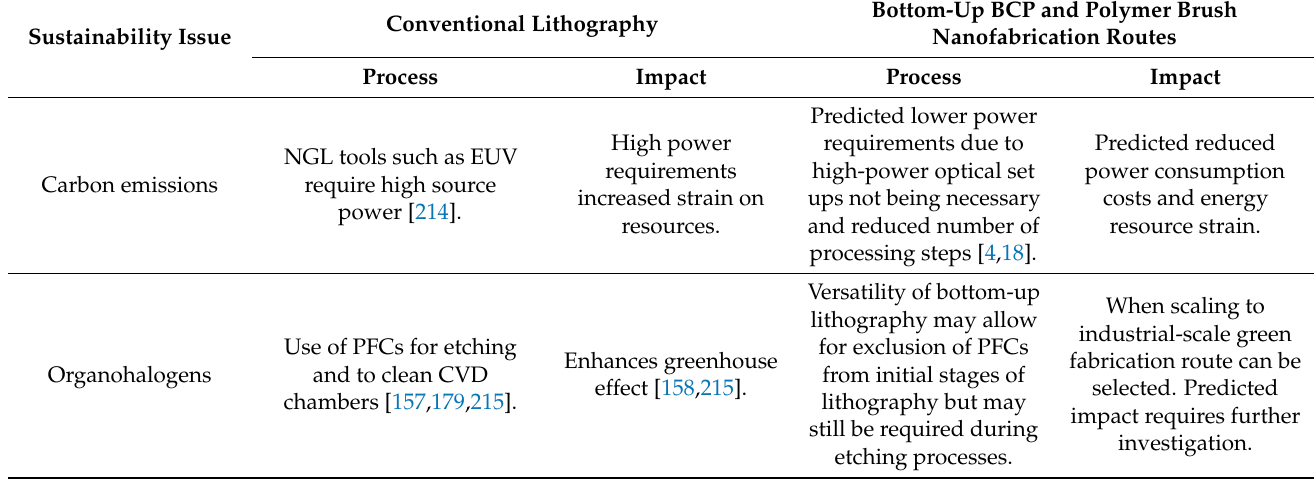
Table 3. Environmental impact of conventional lithographic routes is directly compared to emerging BCP and polymer brush